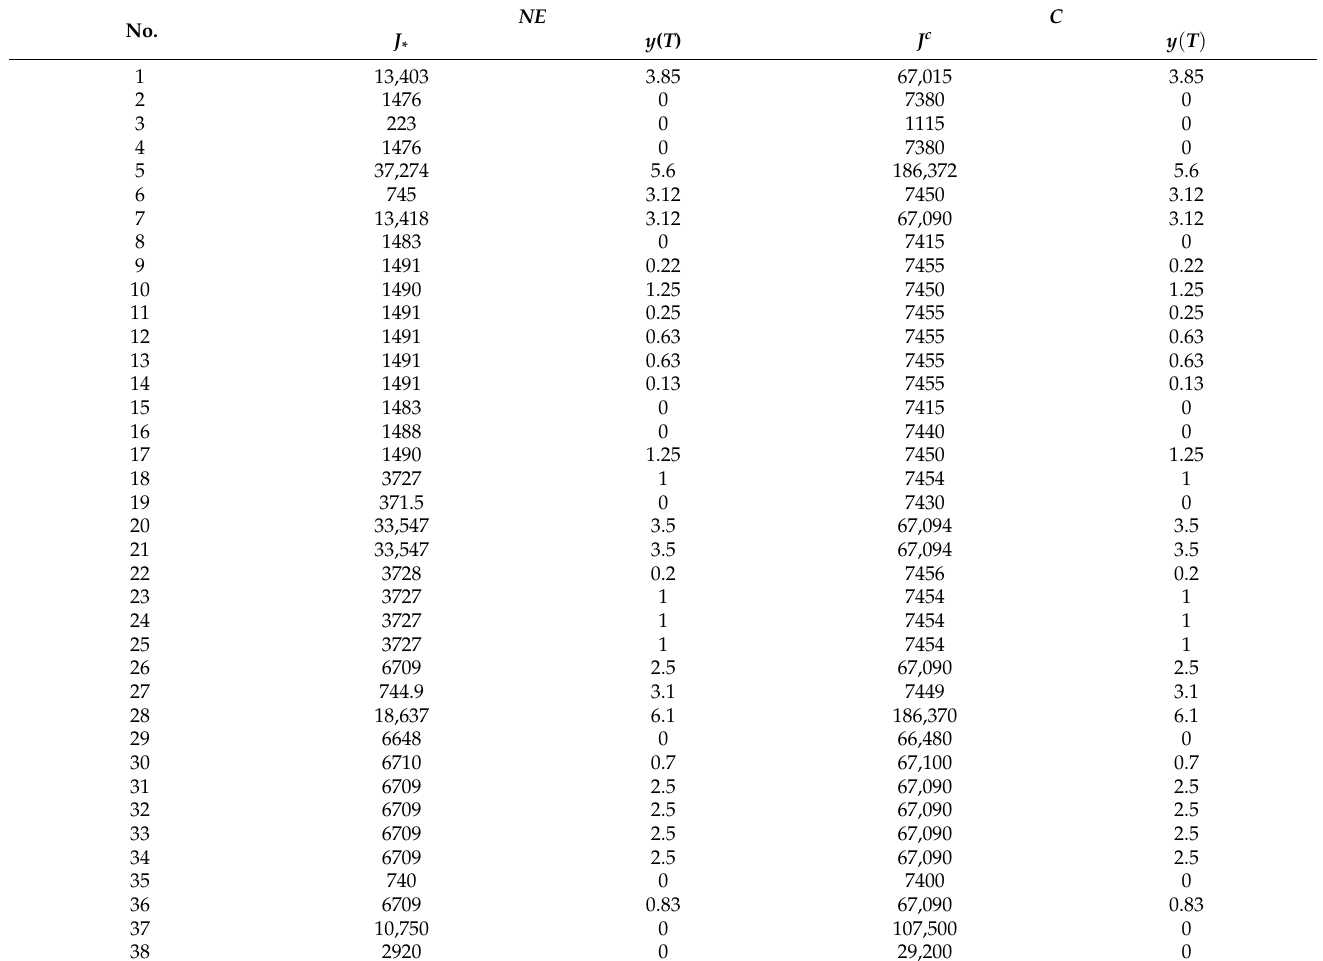
Table 2. Payoffs for different information structures for symmetrical